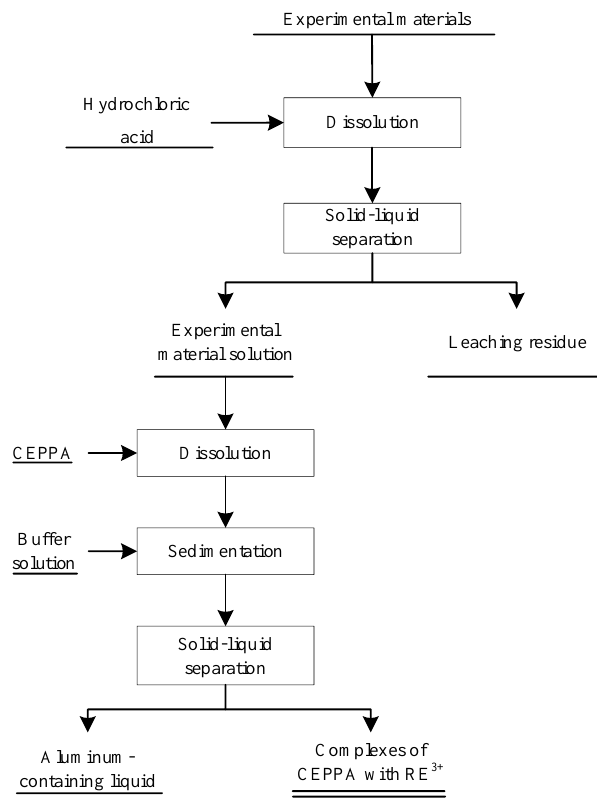
Figure 1. Flow chart of CEPPA aluminum removal experiment.